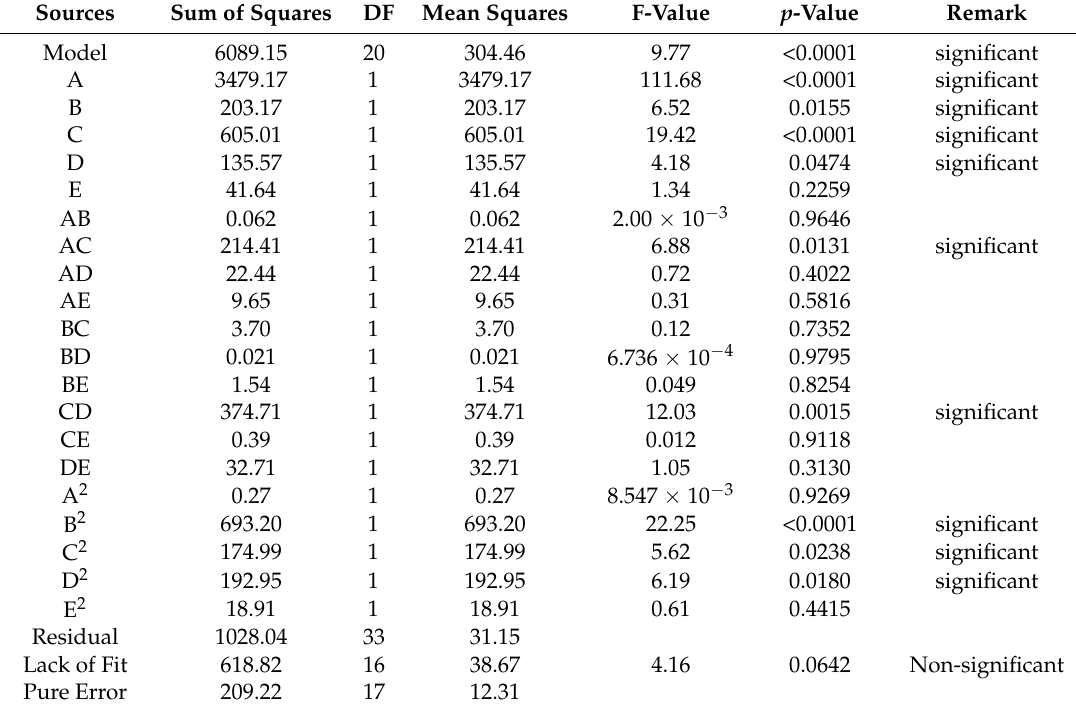
Table 3. ANOVA for the regression model and respective model